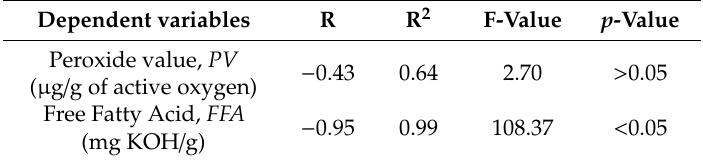
Table 9. ANOVA and correlation results of PV and FFA in relation to heating temperature.